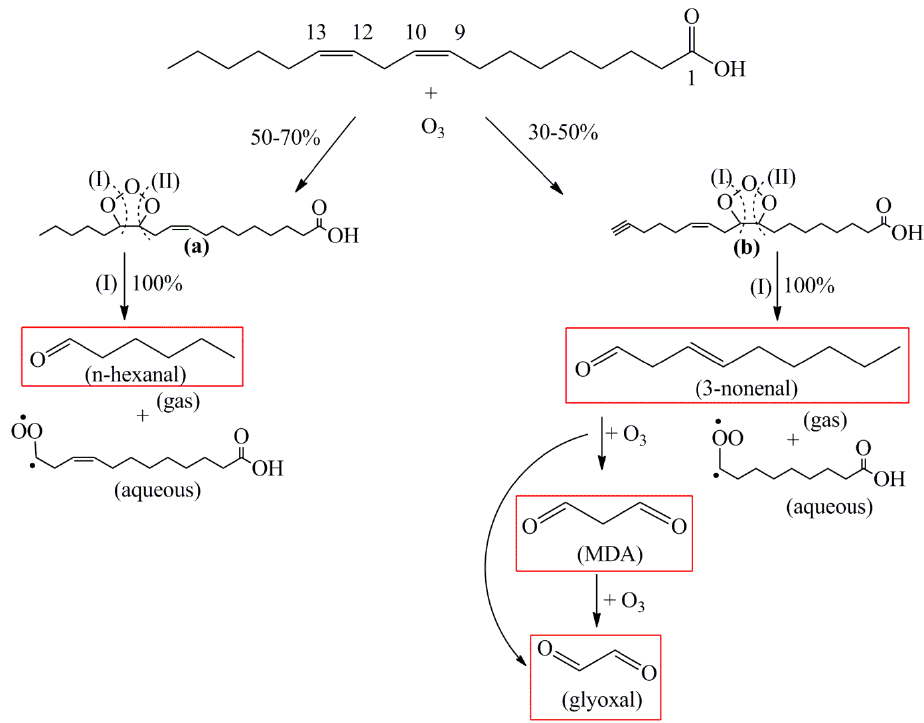
Fig. 6. Reaction mechanism for the heterogeneous reaction of ozone with LA at the air/water interface.